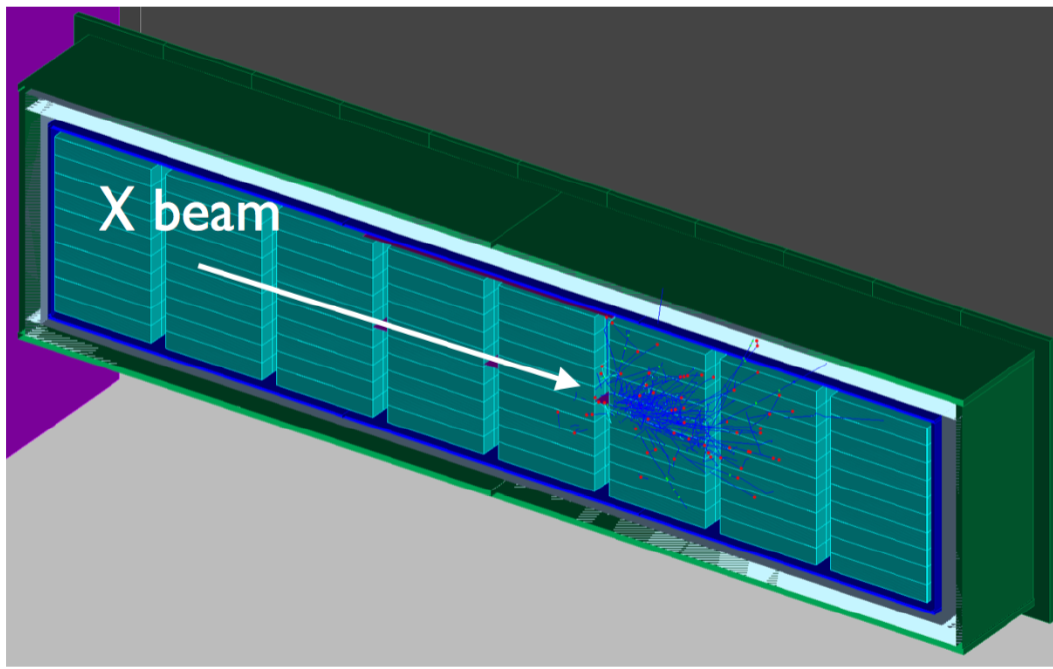
Figure 3. The BDX detector as implemented in GEANT4 [18]. The outer veto is shown in green, the inner veto is gray and the lead vault in blue. Crystals arranged in eight blocks of 10 × 10 are shown in light blue. A simulated electromagnetic shower from a χ -e − scattering in the Ecal is also